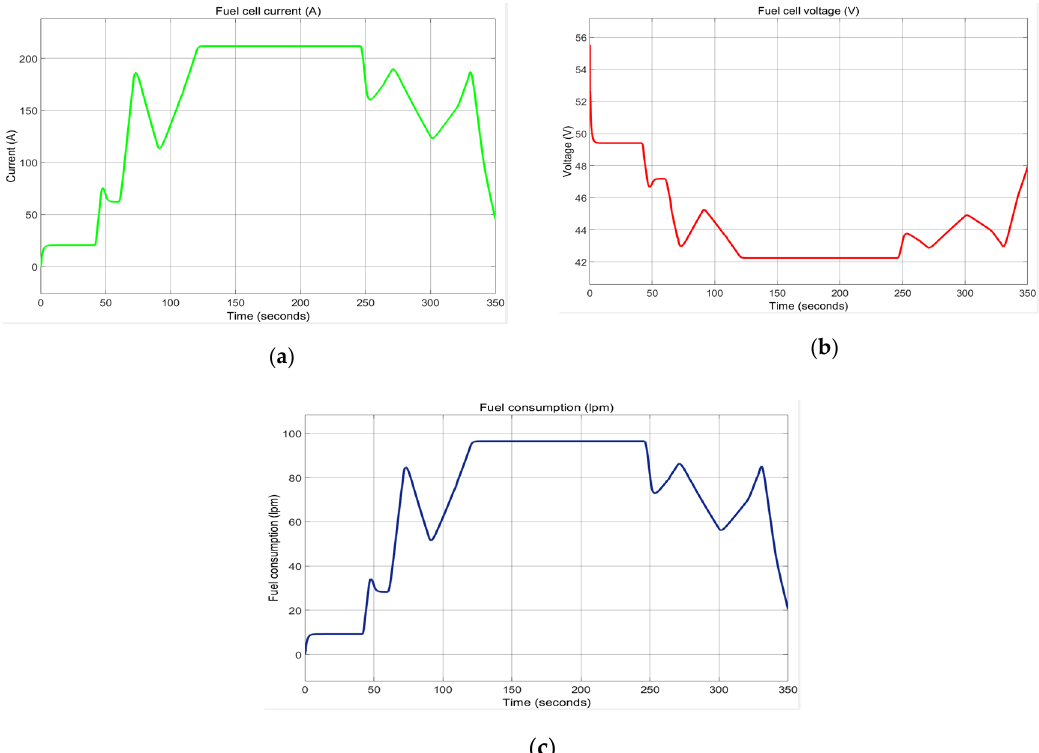
Figure A3. Fuel cell (FC). ( a ) FC current; ( b ) FC voltage; ( c ) FC consumption.